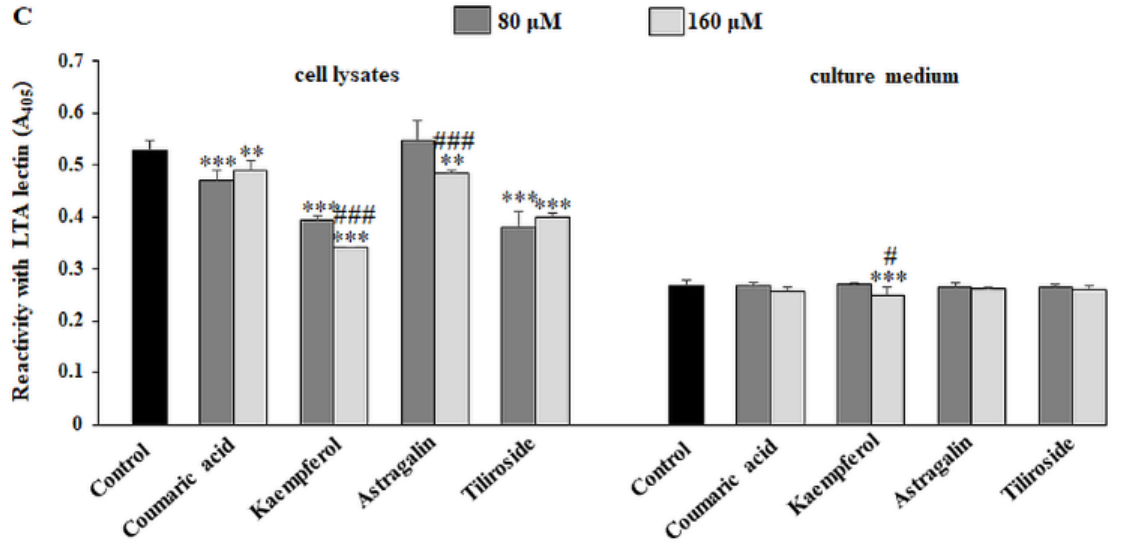
Figure 6. The effect of coumaric acid, kaempferol, astragalin and tiliroside on FUT4 mRNA, FUT4 protein and Fuc α 1,3-GalNAc antigen. The AGS cancer cells were incubated for 24 h with 80 and 160 µ M concentrations of the polyphenolics. mRNA was determined by RT-PCR ( A ). The results are shown as a relative fold change in mRNA expression of genes in comparison to the genes in control, where expression was set at 1. ± SD are the mean of triplicate cultures. *** p < 0.001 compared to untreated control; ## p < 0.01, ### p < 0.001 compared to lower concentration (80 µ M) of specific polyphenolic compound. FUT4 protein expression was assessed by Western blot analysis ( B ). β -actin served as a protein loading control. The intensities of the bands were quantified by densitometric analysis. Data represent the mean ± SD of triplicate culture. ** p < 0.01, *** p < 0.001 compared to untreated control; # p < 0.05, ### p < 0.001 compared to lower concentration (80 µ M) of specific polyphenolic compound. Fuc α 1,3-GalNAc antigen relative expression in cell lysates and culture medium was analyzed by ELISA tests with biotinylated lectins (LTA recognizing fucosylated antigen) ( C ). The results are expressed as absorbance at 405 nm after reactivity with the lectin. Values ± SD are the mean from three independent assays. ** p < 0.01, *** p < 0.001 compared to untreated control; # p < 0.05, ### p < 0.001 compared to lower concentration (80 µ M) of specific polyphenolic compound.